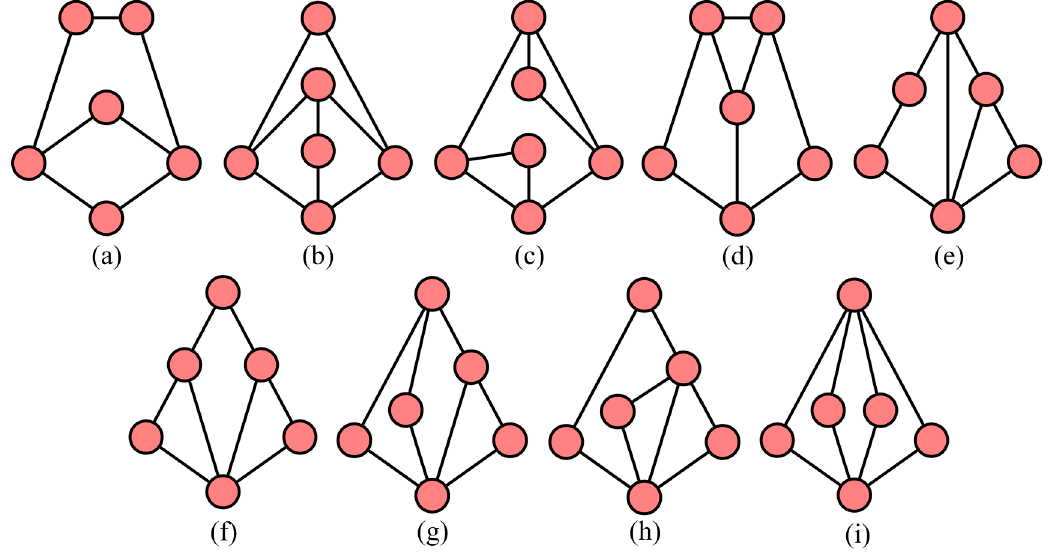
Figure 4. GKCs of mechanisms using eight joints and six links.